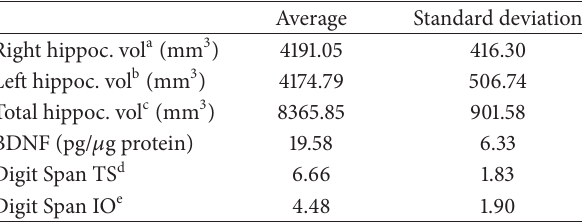
Table 3: MRI/working memory results ( 𝑁 = 27 ). Average Standard